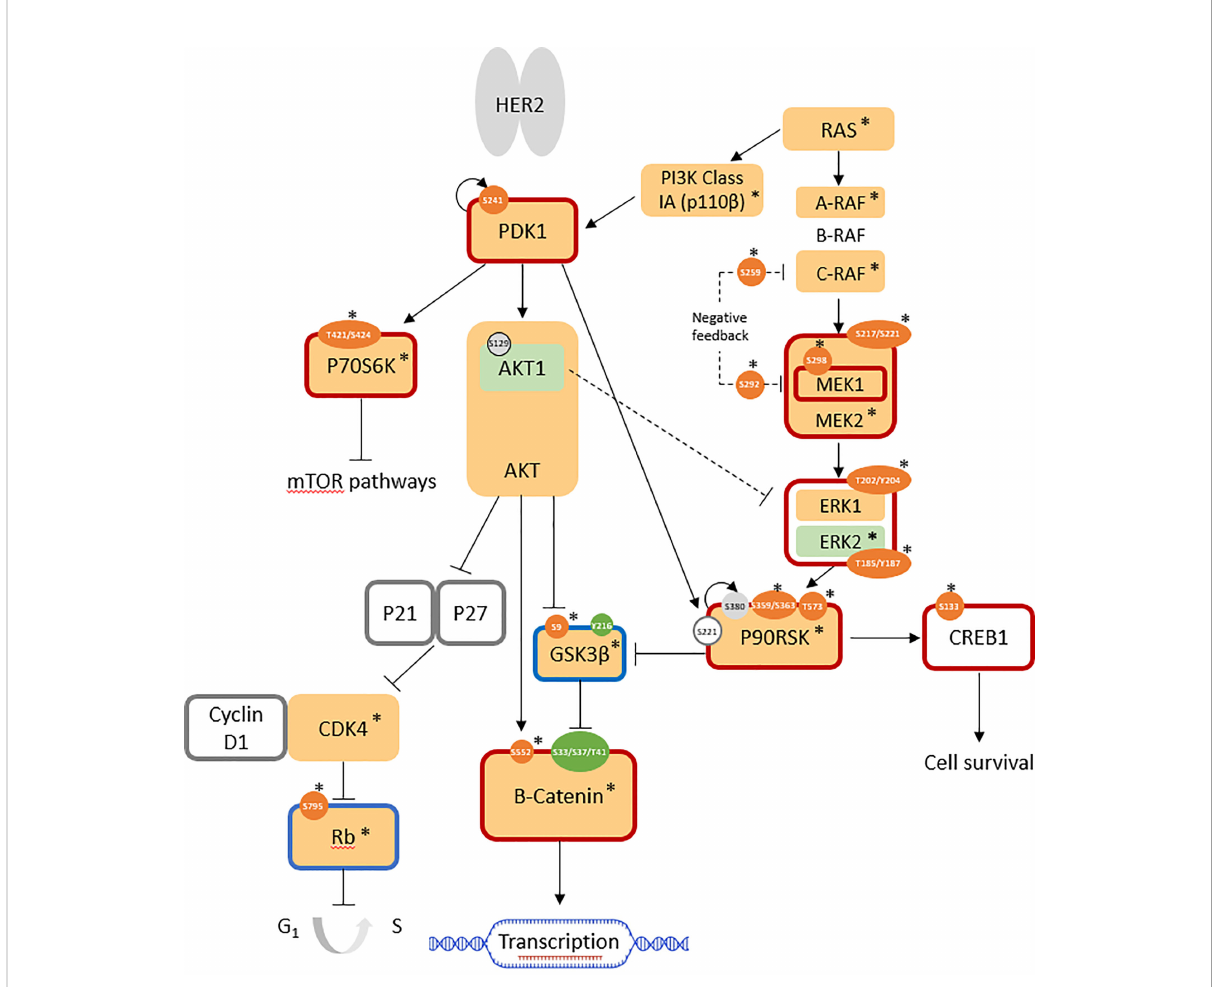
FIGURE 2 Pathways involved in JIMT-1 trastuzumab resistance (log 2 FC normalized to SKBR3 signals). AFISimilarly expressed protein: light grey; antibody not available/poor performance: no fi ll; overexpressed total protein ≥ 1.5-fold (log 2 FC ≥ 0.58): light orange; ≥ 2-fold: *; under-expressed total protein ≤ 0.67 (log 2 FC ≤ -0.58): light green; ≤ 0.5-fold: *; overexpressed phosphosite ≥ 1.5-fold: orange; ≥ 2-fold: *; underexpressed phosphosite ≤ 0.67: green; ≤ 0.5-fold: *; predicted active protein: dark red outline; predicted inactive protein: dark blue